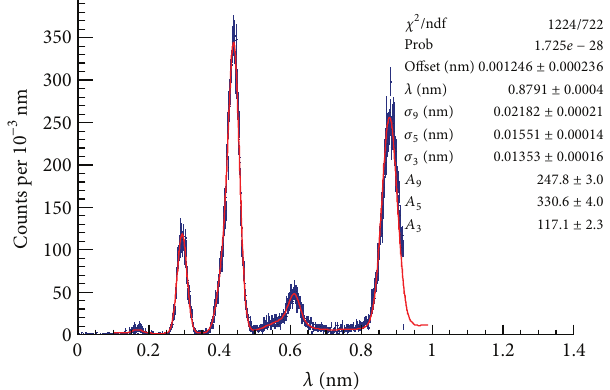
Figure 4: Long-distance (78 cm) TOF spectrum. It is assumed that the three main peaks arise from the three first orders of Bragg diffraction which fixes the wavelengths 𝜆/2 and 𝜆/3 for the second and third order peaks. There are 21 other free parameters to account for the offset of the 𝑋 -axis, the amplitudes and width of the Gaussian peaks, as well as ad hoc background description.